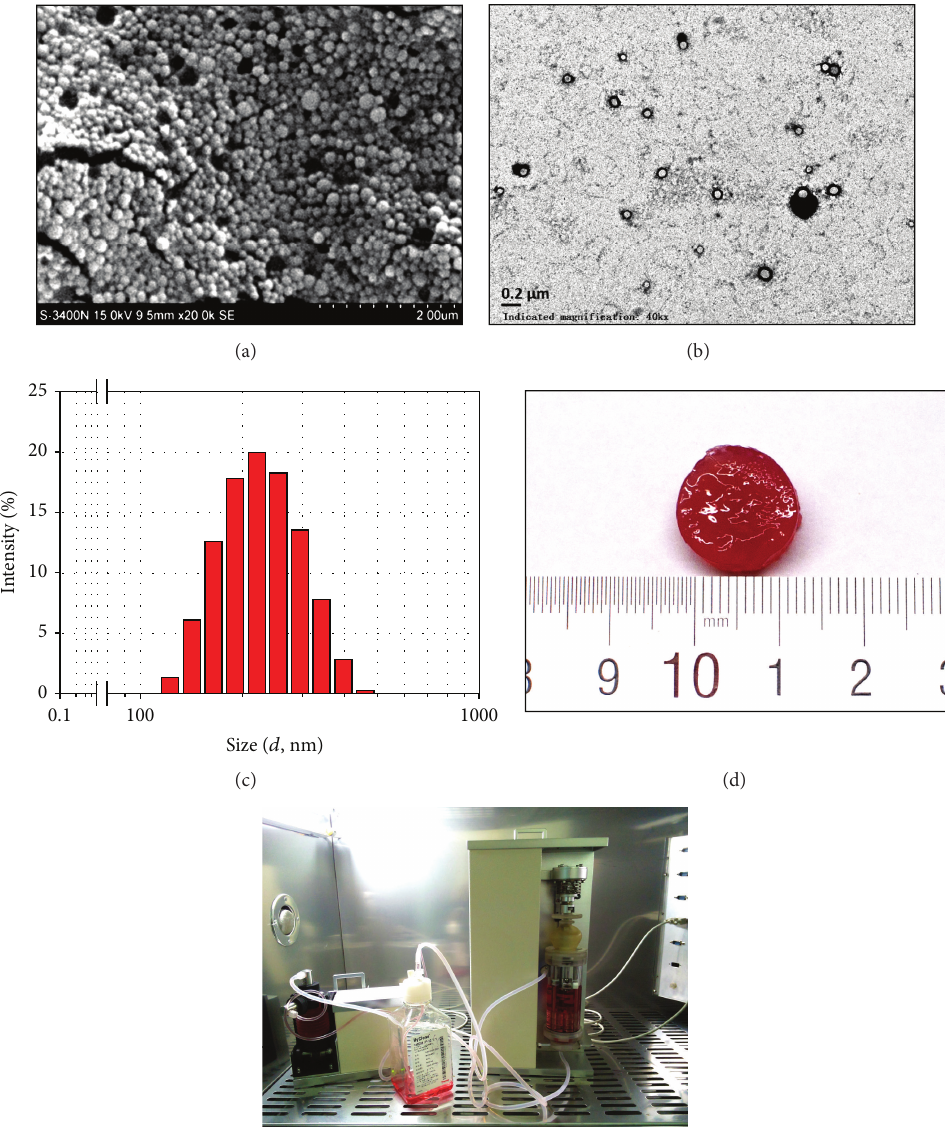
Figure 2: (a) Scanning electron microscopy micrographs of the TGF- 𝛽 3-loaded PLGANPs (magnification: 50,000x, scale = 2 𝜇 m); (b) transmission electron microscopy of the TGF- 𝛽 3-loaded PLGANPs (magnification: 500,000x, scale = 0.2 𝜇 m), showing good dispersibility of the PLGANPs; (c) size distributions of the TGF- 𝛽 3-loaded PLGANPs; (d) general views of the codelivery system of the MSCs encapsulated dextran/gelatin hydrogel with the TGF- 𝛽 3-loaded PLGANPs after 28 days’ in vitro culture; (e) a custom-made bioreactor system, including integrated servomotor and circulating system, for promoting TE-NP tissue